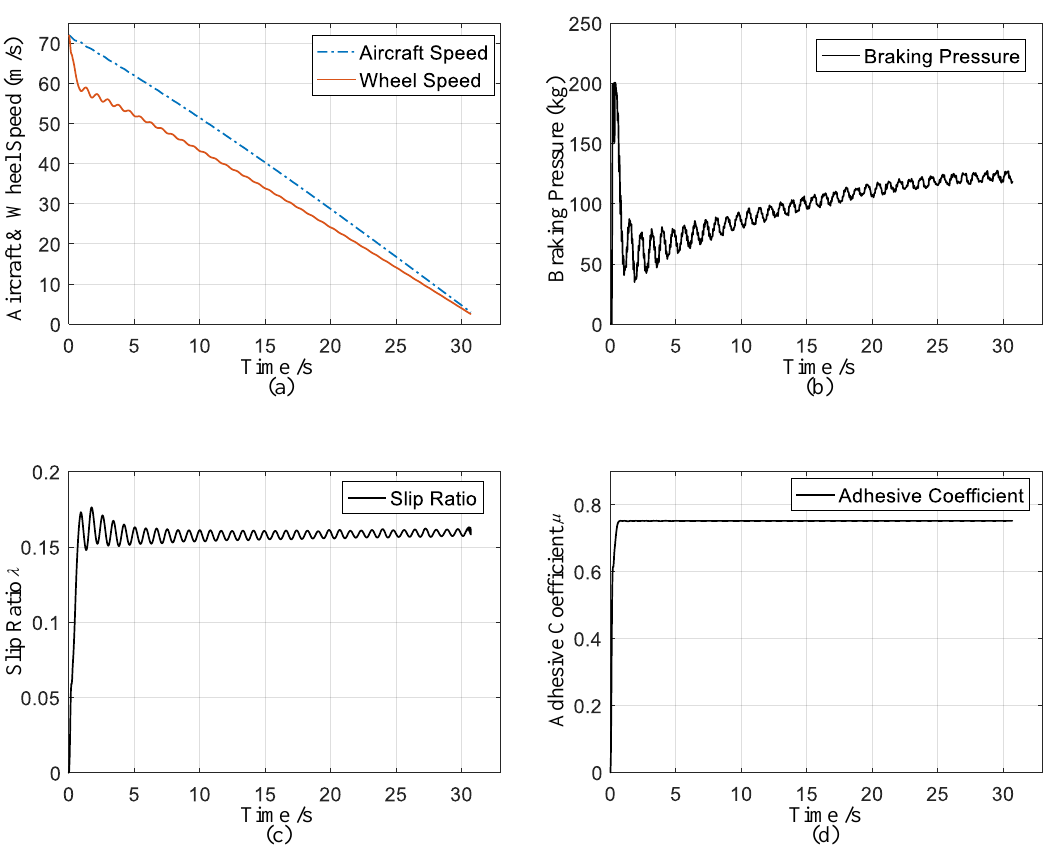
Figure 7. HIL experimental results. ( a ) Aircraft and wheel speed; ( b ) Braking pressure; ( c ) Slip ratio; ( d ) Adhesive coefficient between the wheel and the runway.